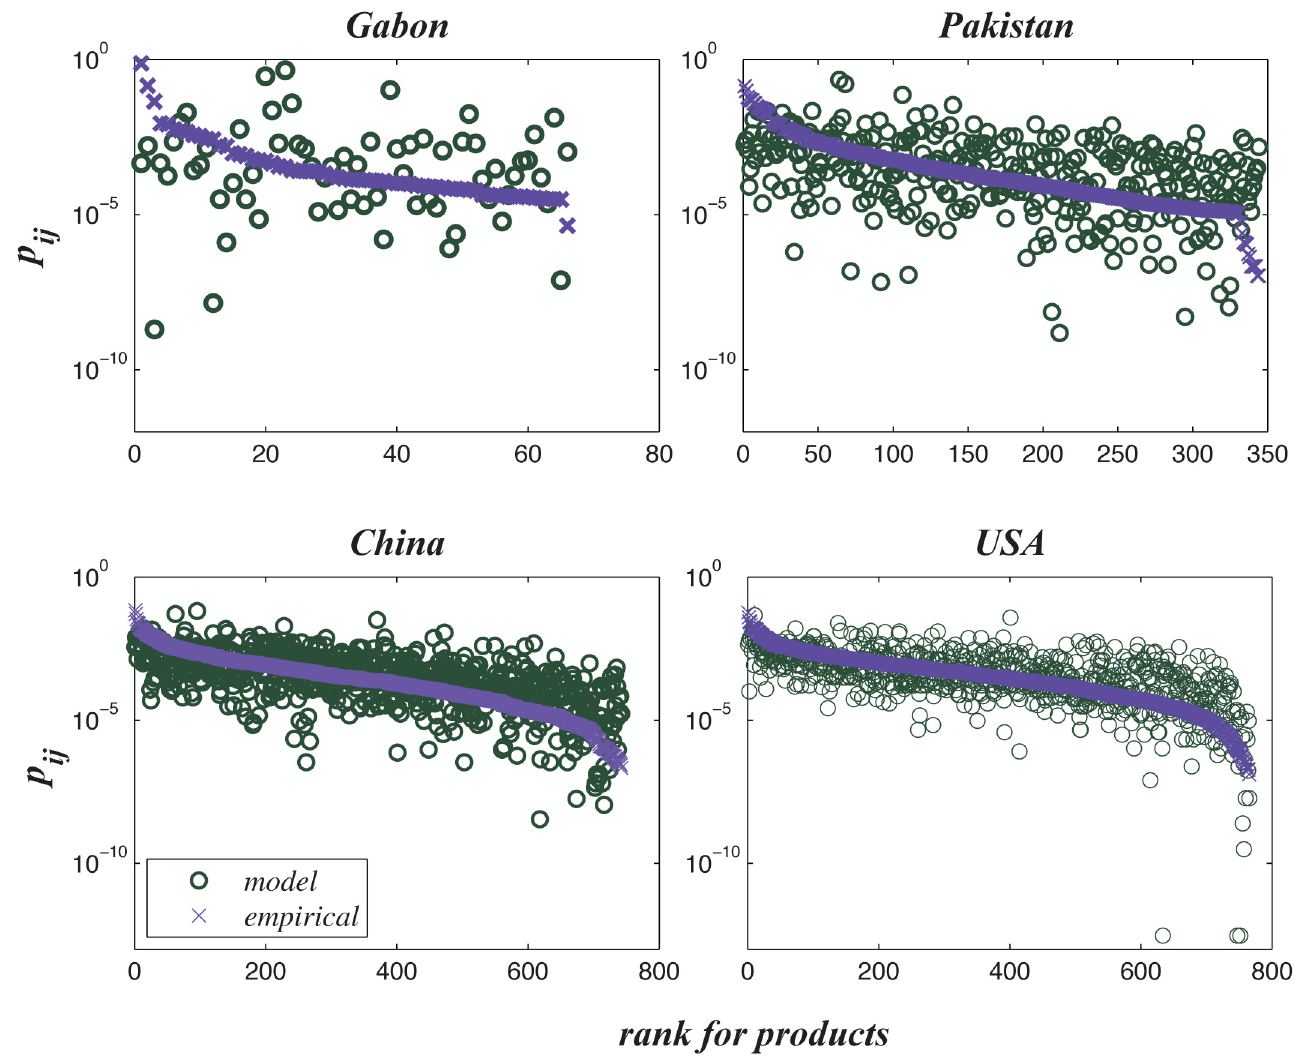
Fig 7. Theoretical p ij with original rank orders of all products for the four selected